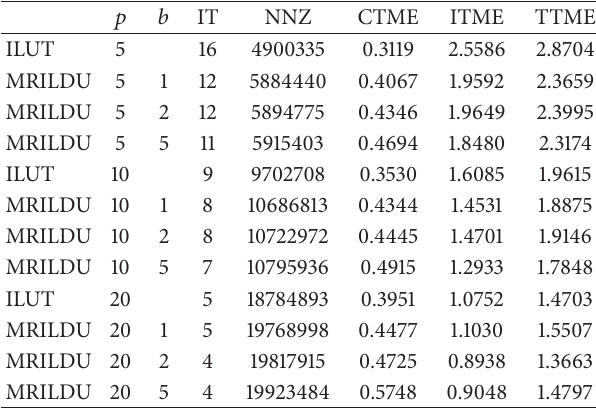
Table 2: Iteration results for matrix af shell10. Table 3: Iteration results for matrix